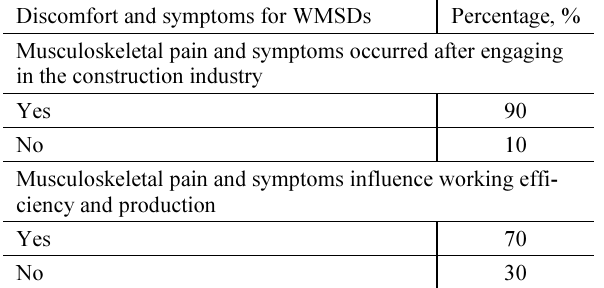
Table 3. Survey on the workers’ frequency of pain occurrence Discomfort frequency